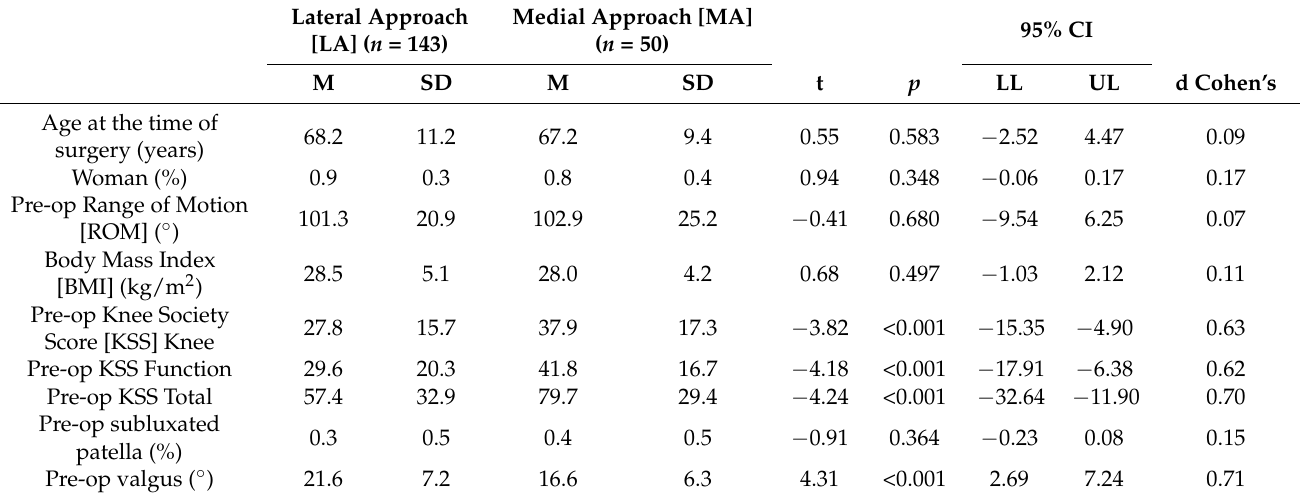
Table 2. Patients’ demographic and pre-operative